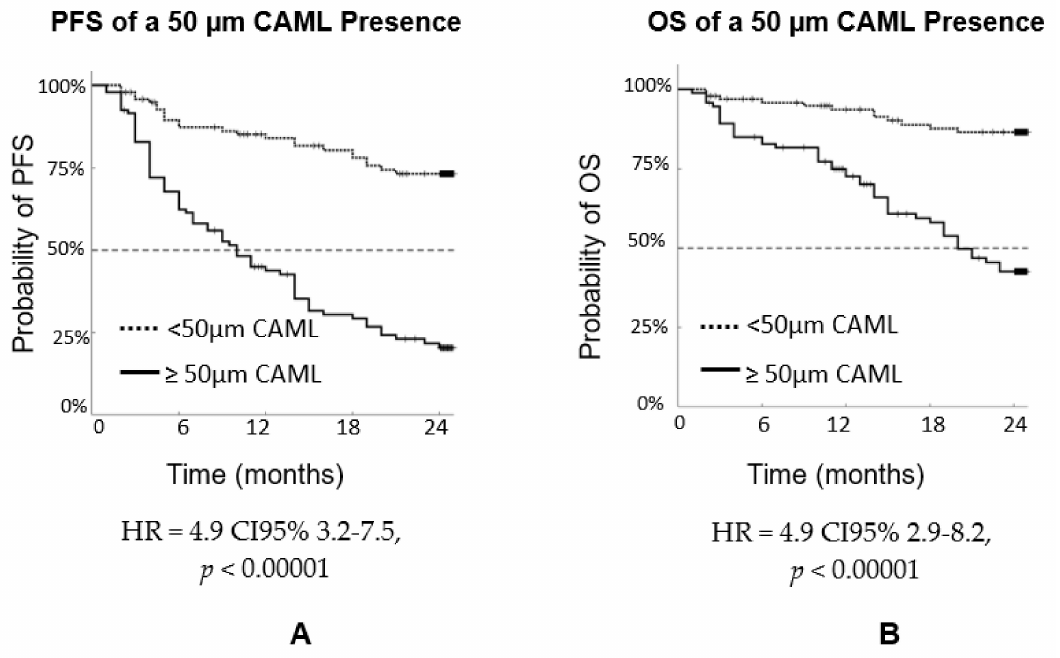
Figure 10. PFS of n = 192 patients with three types of cancers (breast, prostate, and lung) by stage ( A ) PFS and ( B ) OS based on CAML size, combining all